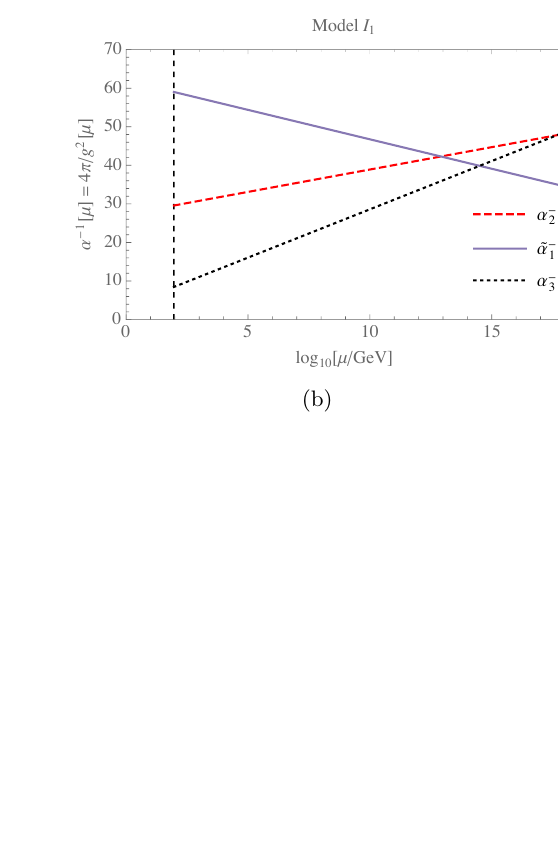
, we plot the rede(cid:12)ned quantity 1